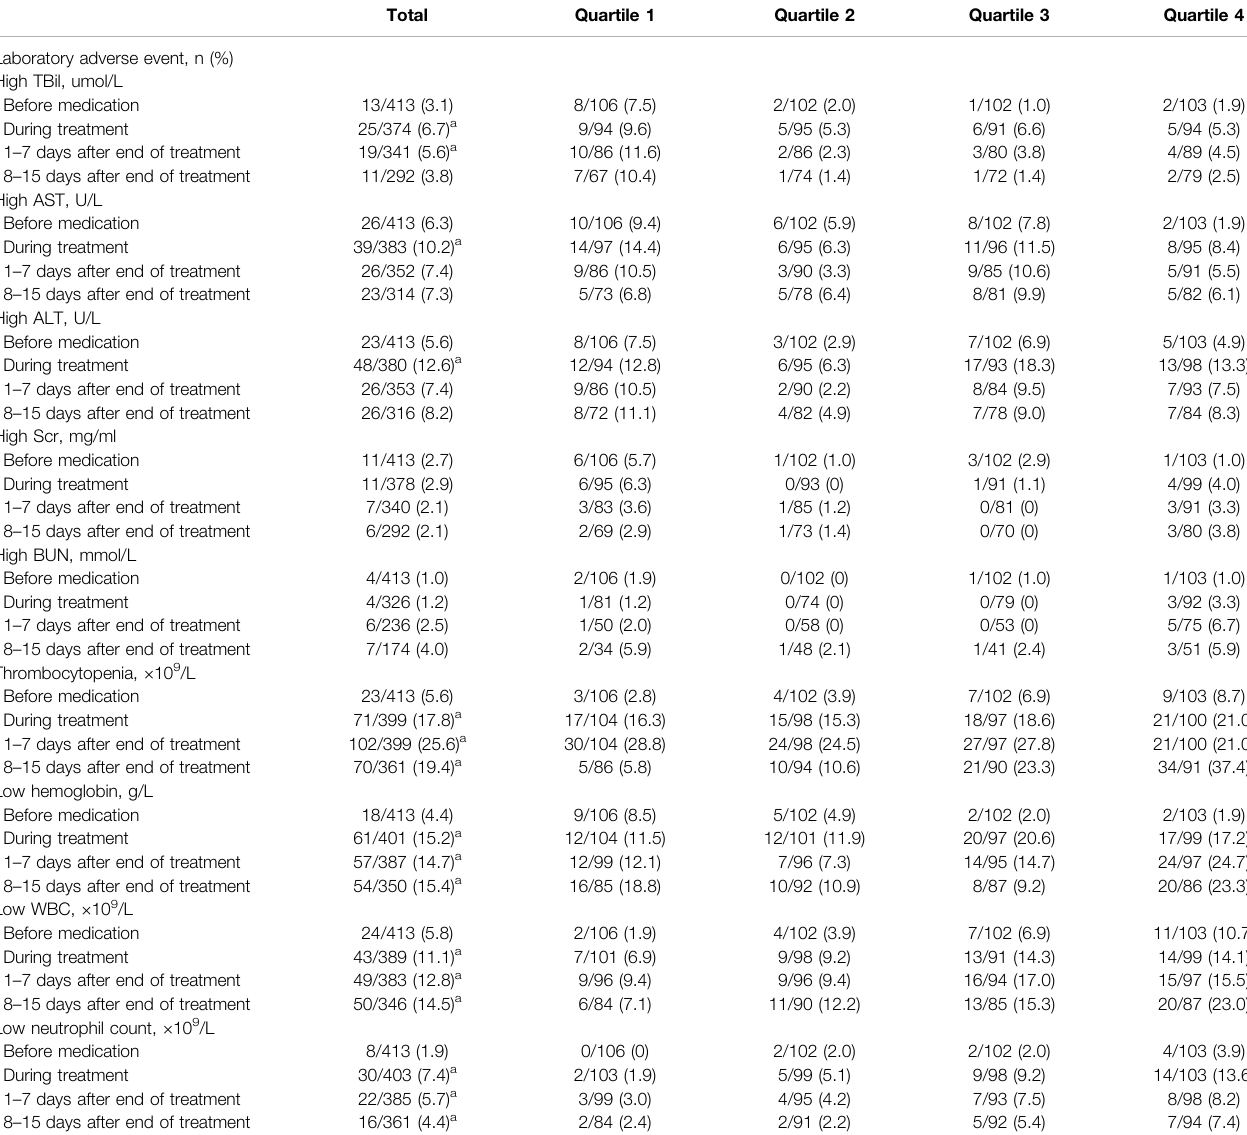
TABLE 3 | Counts and percentages of the laboratory adverse events and the change over time before and after linezolid treatment according to the AUC 24